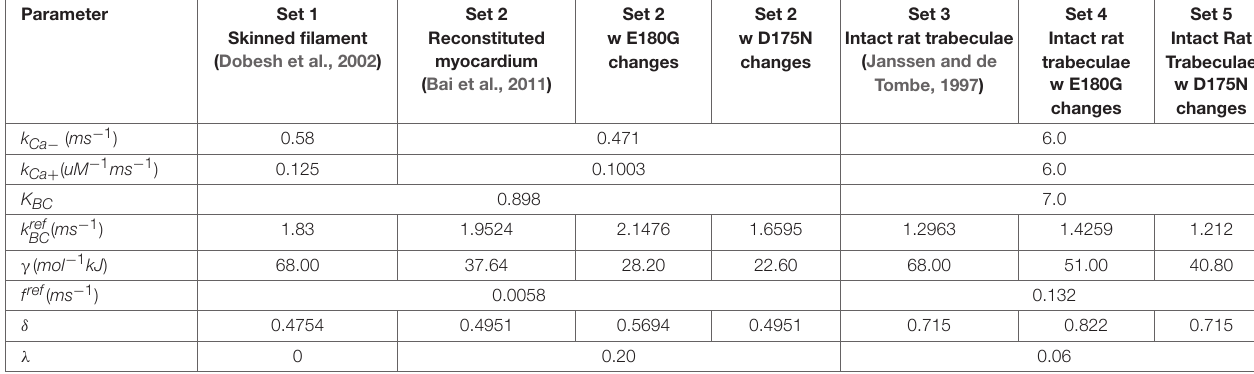
TABLE 1 | Parameters used for fitting data and running simulations. Parameter